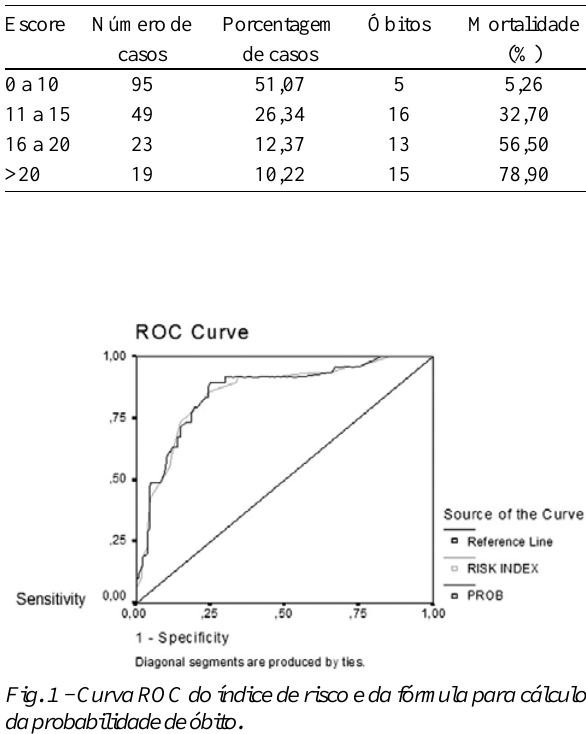
Tabela 5. Mortalidade segundo o índice de risco.